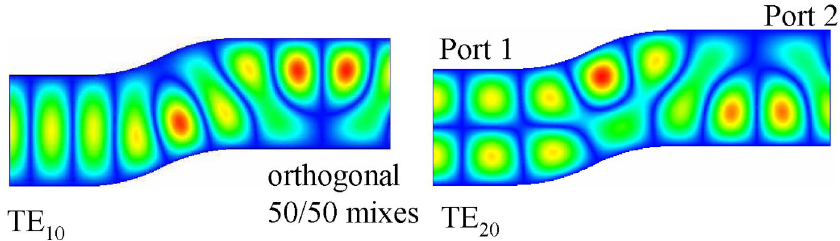
FIG. 2. (Color) HFSS simulation of the jog mode converter. The colors represent a time snapshot of the electric field